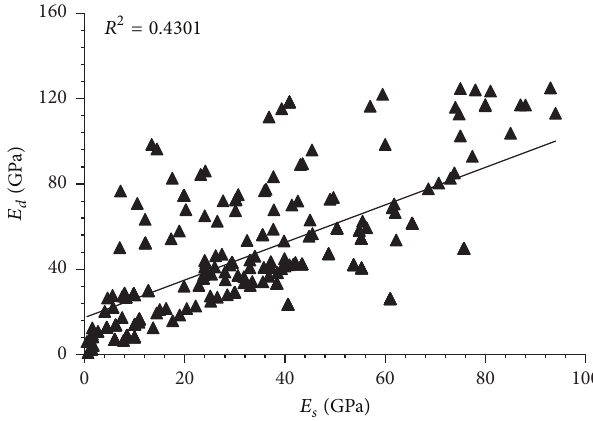
Figure 3: Measured versus predicted 𝐸 𝑠 for data used to train the GEP model.